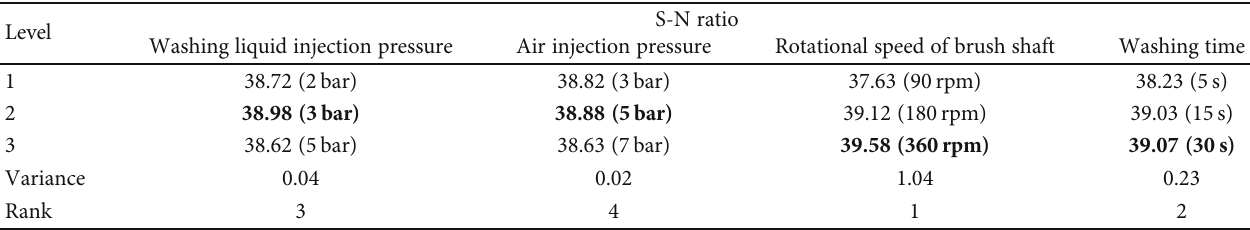
Table 5: Analysis of variance. (a) Analysis of variance for S-N